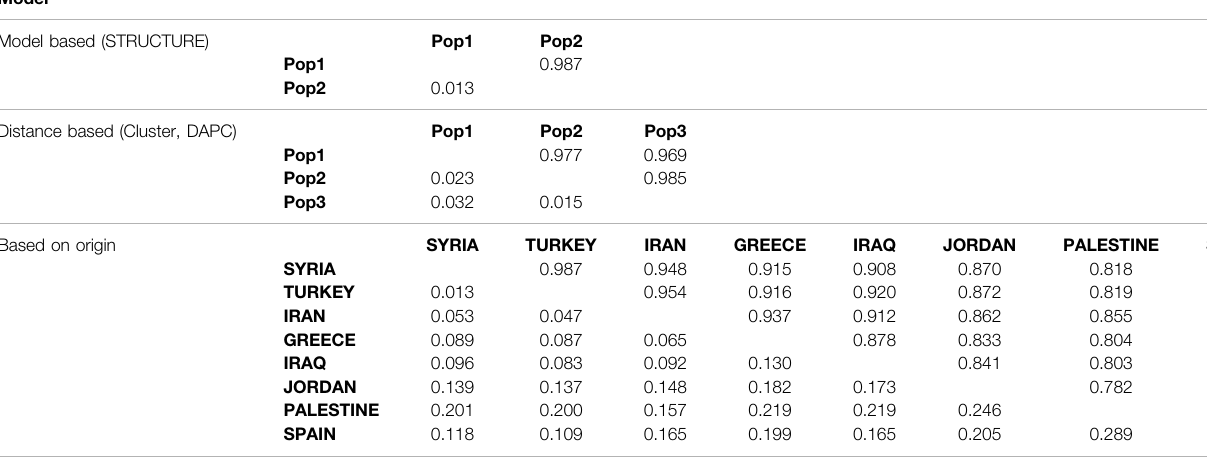
TABLE 3 | Nei ’ s genetic identity (above diagonal) and genetic distance (below diagonal). Model